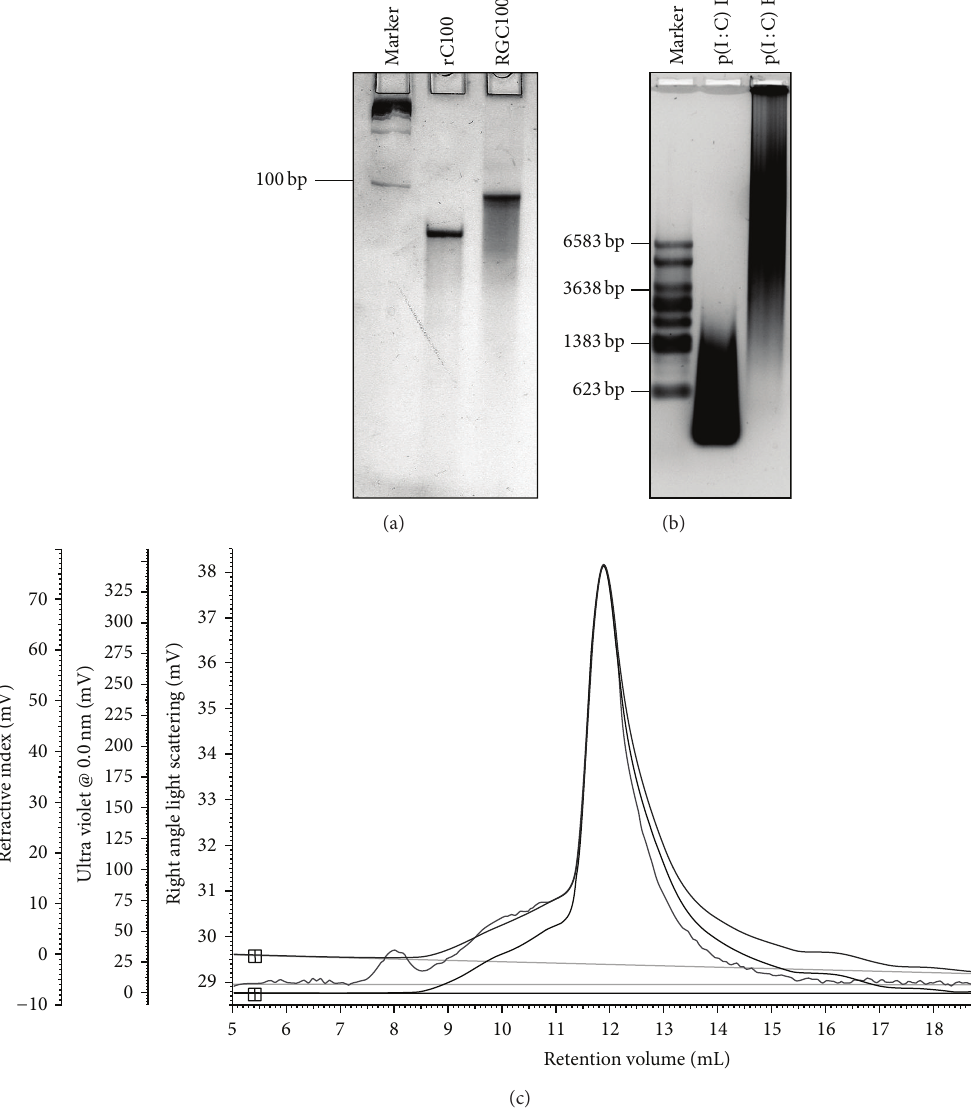
Figure 1: Determination of physicochemical properties of RGC100. (a) Analysis of RGC100 by 12% native PAGE. RGC100 displays a length of 100bp as indicated. It consists of 100 rC bases paired to 100 rG bases, perfectly annealed in a double strand. As a reference, a 100mer consisting of homopolymeric cytidine is shown. (b) Analysis of poly(I:C) by 1% native agarose gel electrophoresis. p(I:C) LMW: poly(I:C) with a low molecular weight. p(I:C) HMW: poly(I:C) with a high molecular weight. (c) Analysis of RGC100 by size-exclusion chromatography